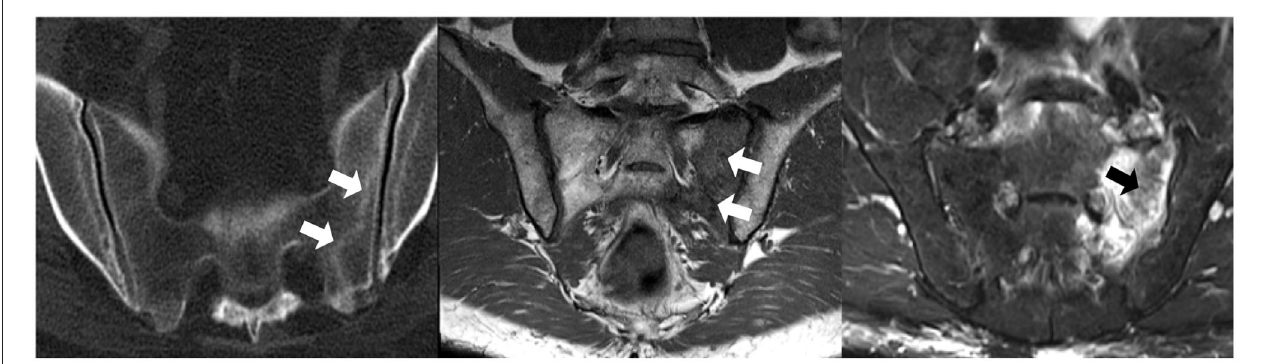
FIGURE 8 | CT (left), T1WI (middle), and fat-saturated PD (right) MRI of a patient with sacral insufficiency fractures (arrows). T1WI shows diffuse slightly hypointense signal of the left sacral wing and a linear hypointensity compatible with a sacral fracture; corresponding fat-saturated PD image documents marked bone marrow